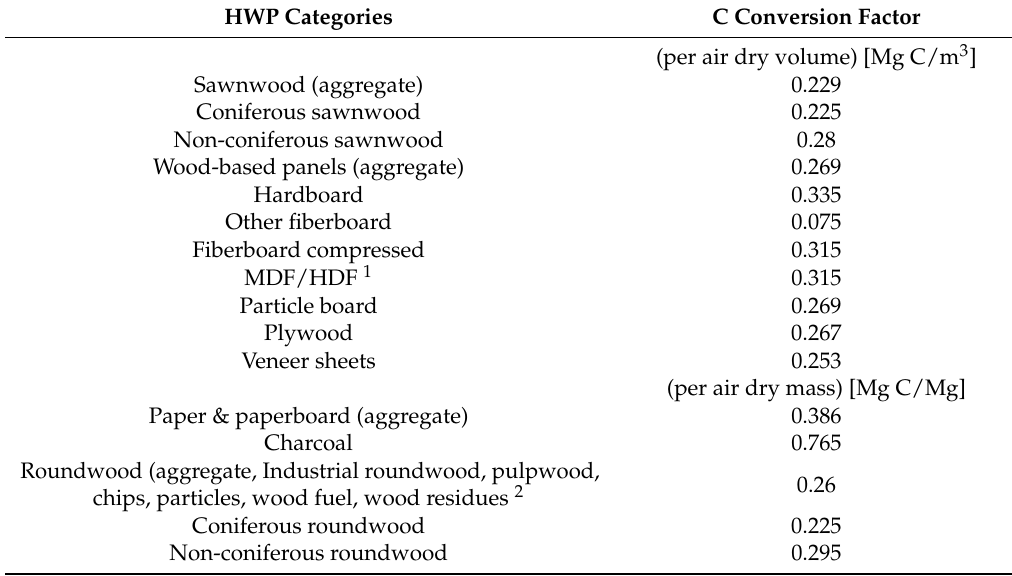
Table 1. Carbon conversion factors in HWPs used in the